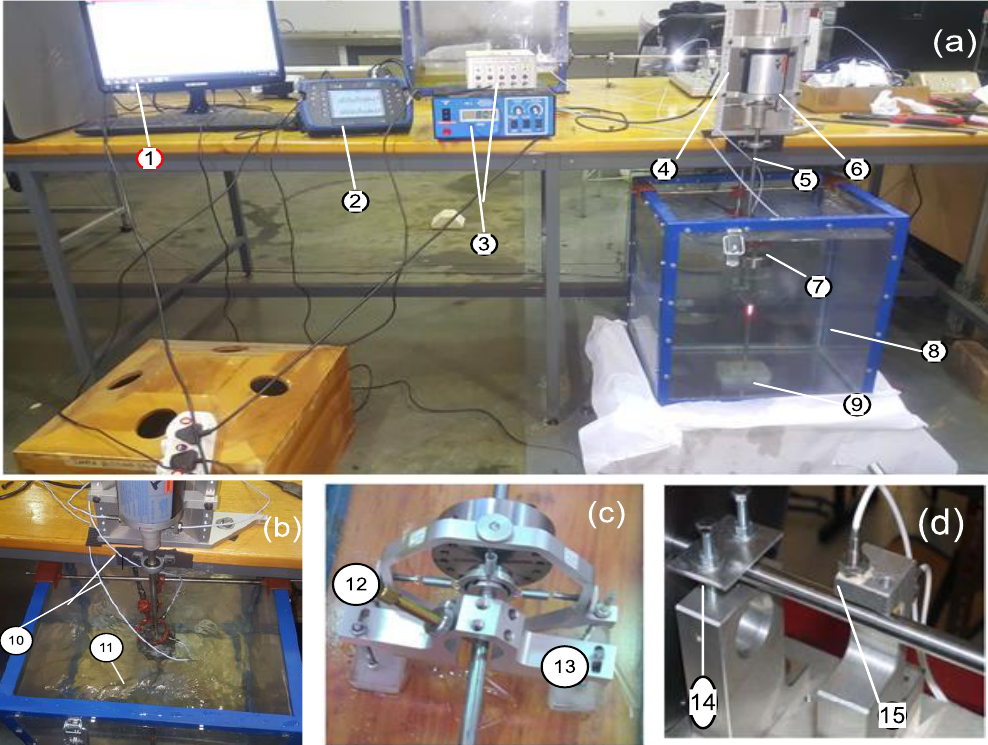
Figure 5. Miniature drilling rig model for experimental analysis. ( a ) 1-Computer screen, 2-ccout-2013, 3-speed control junction box, 4-frame support, 5-vertical shaft, 6-motor, 7-disc, 8-tank, 9-granitic rock sample; ( b ) 10-probe sensors, 11-water; ( c ) 12-rub screw, 13-rub housing; ( d ) 14, 15 – 90° mounted sensors.